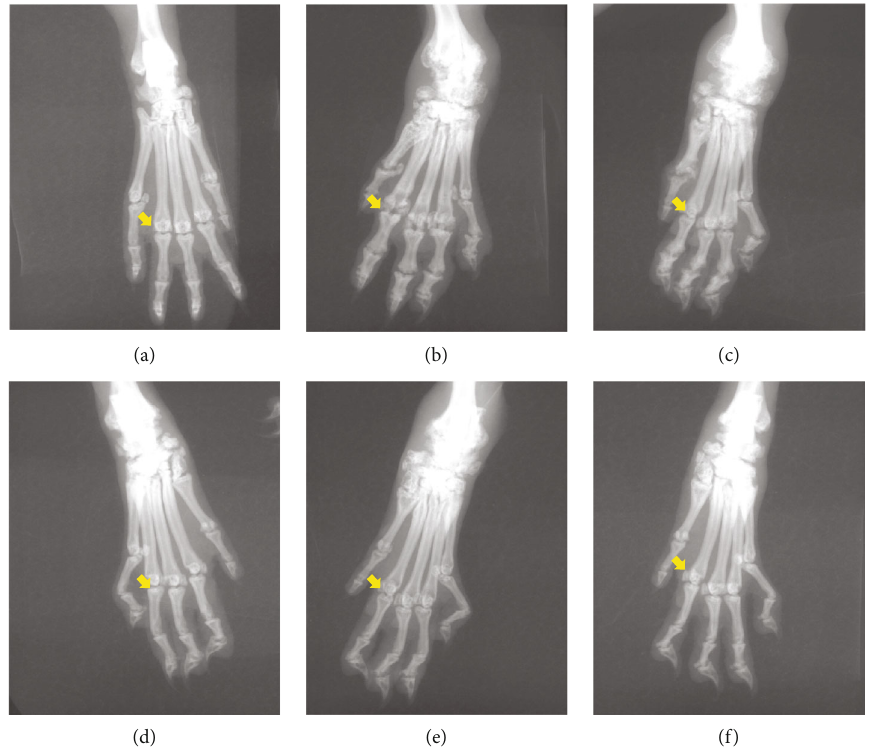
Figure 3: X-ray was used to evaluate the therapeutic e ff ects of matrine and MTX on CIA rats: (a) healthy group; (b) CIA control group; (c) low dosage matrine group (25 mg/kg matrine group); (d) medium dosage matrine group (50 mg/kg matrine group); (e) high dosage matrine group (100mg/kg matrine group); (f) methotrexate group (2 mg/kg MTX group). Obvious joint damage and part of the joint space disappearance could be observed in (b). In (c – f), the degree of joint damage was lower than that in